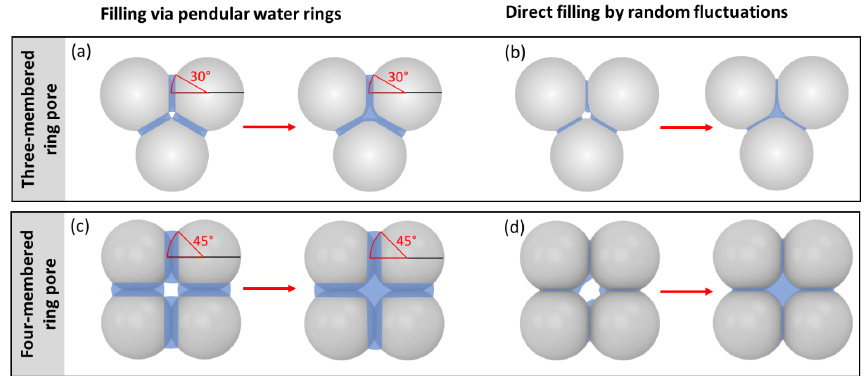
Figure 4. Illustration of the filling scenarios for (a, b) three-membered and (c, d) four-membered ring pores formed between spheres in a tetrahedral and cubic packing arrangement assuming θ sw is 60 ◦ . In the three-membered and four-membered ring pore case, uptake of liquid water is considered either by filling via the pendular rings of water (a, c) or by direct filling (b, d) . Direct filling starts at the pore neck, defined as the narrowest point of the ring pore opening located at the midplane between the centres of the spheres. In the case of filling via the pendular water rings slit-filling angles of ε = 30 ◦ and ε = 45 ◦ (red marking) need to be reached for pendular rings to gather together and coalesce. Note that for θ sw = 60 ◦ , the water surface has a convex curvature at a filling angle of ε = 45 ◦ . If the RH is further increased, further filling of the ring pore as well as of the inner cavity (concave octahedron and concave cube) takes